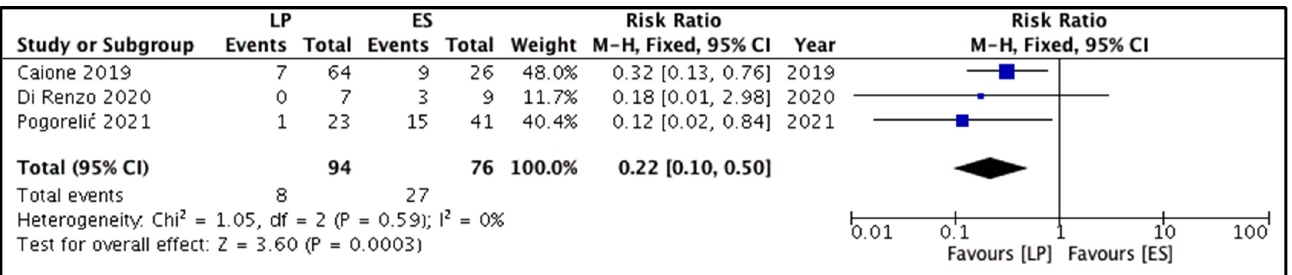
Figure 5. Forest plot comparison between the two patient groups in terms of the requirement for anti-reflux surgeries (excluding other secondary procedures). Legends: LP, laser puncture patient group. ES, electrosurgical incision patient group. M-H, Mantel-Haenszel method. CI, confidence interval.